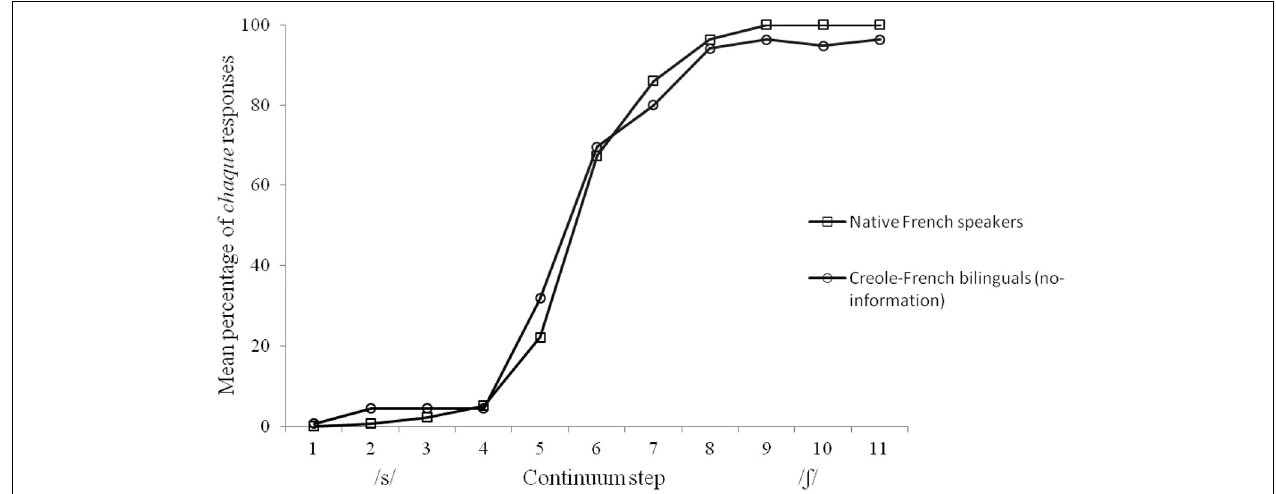
FIGURE 1 | Mean percentage of chaque responses for each stimulus of the /s/-/ S / continuum in the Native French speakers group and in the Creole-French bilinguals group (no-information).